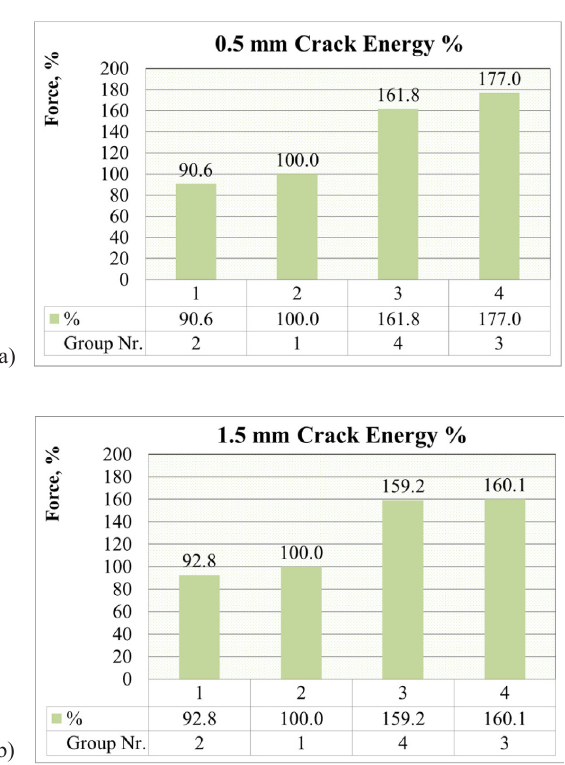
Fig. 10. Energy spent reaching COD equal to 0.5 mm (a), and 1.5 mm (b), Group 1 is designated as